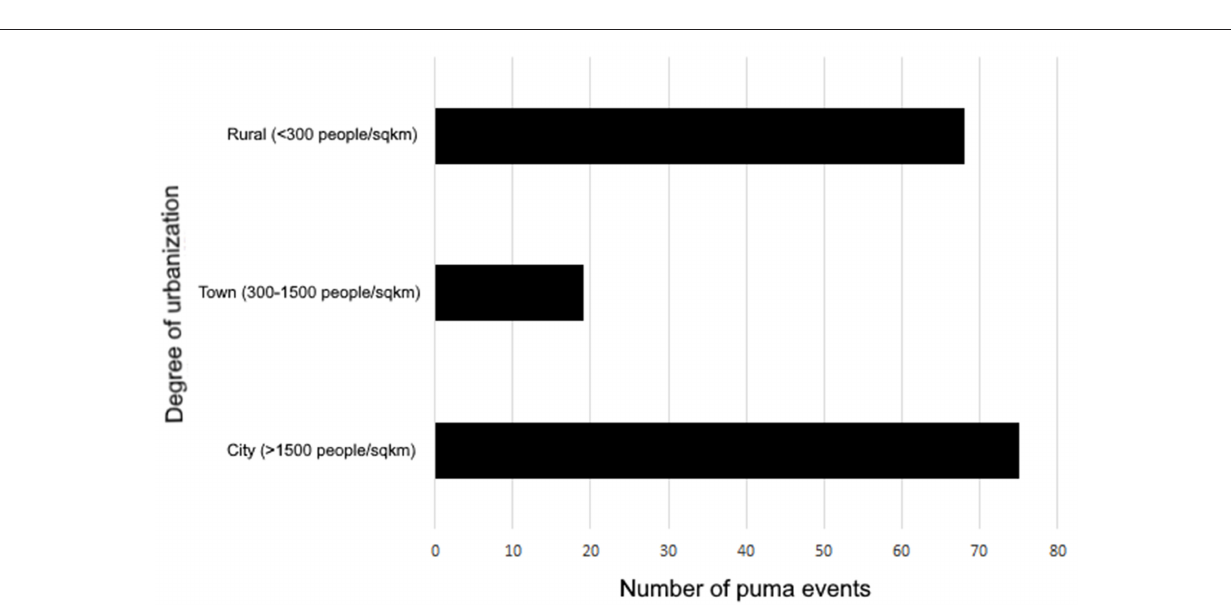
FIGURE 5 | Percentage of the news that presented information regarding the management of the captured individuals.